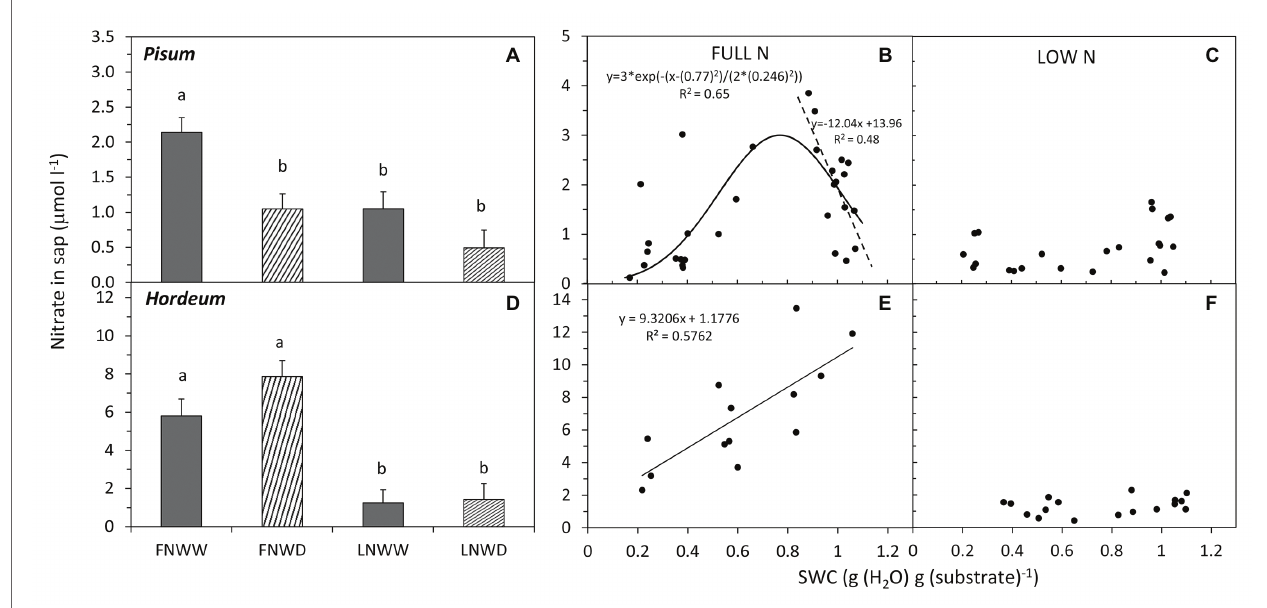
FIGURE 5 | Mean NO3 − concentration in xylem sap of P. sativum (A,B,C) and H. vulgare (D,E,F) plants after 2–6 days treatment with different water and nitrogen availability. FNWW plants received 4 mM NO3 − daily, FNWD plants received 4 mM NO3 − at the start but no water during the sampling period, LNWW plants received 0.2 mM NO3 − daily, and LNWD plants received 0.2 mM NO3 − at the start but no water during the sampling period. The graphs (A,D) show means in each treatment ± SE ( n = 6–17). Significant differences ( p ≤ 0.05) between treatments were tested separately for each species and are marked by different letters. Dynamic changes of NO3 − concentration in sap with declining substrate water content (SWC) are shown in (B,C) for P. sativum ; (E,F) for H. vulgare under full (FN) and low (LN) NO3 − availability. Significant relationships are marked by a regression line with the corresponding equation. In graph (B) , the separate linear regression line was fitted only to SWC above 0.7 g.g −1 (significant at p ≤ 0.003). FN, full nitrogen; LN, low nitrogen; WW, well-watered; and WD, water